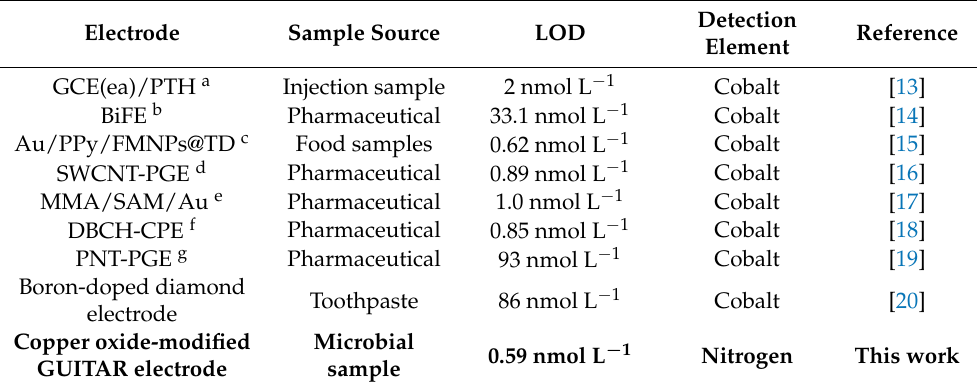
Table 1. Performance of some electrochemical VB12